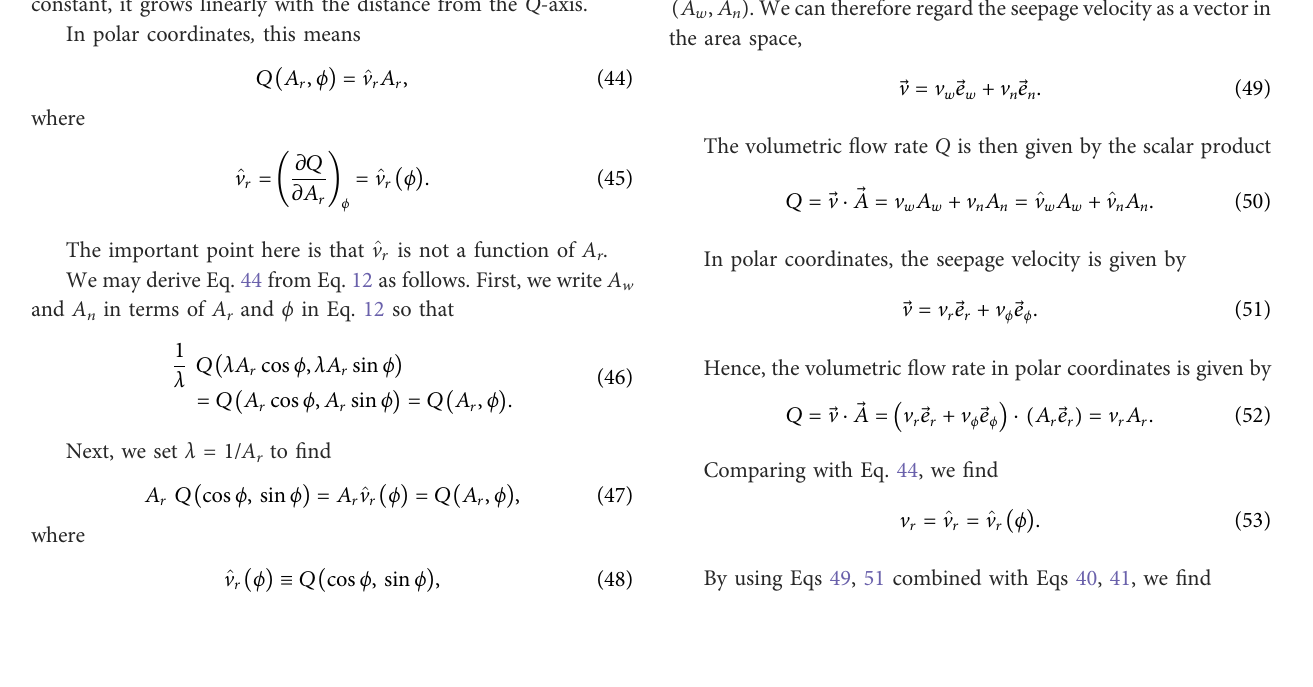
Q p 1 and 2 in the limit of